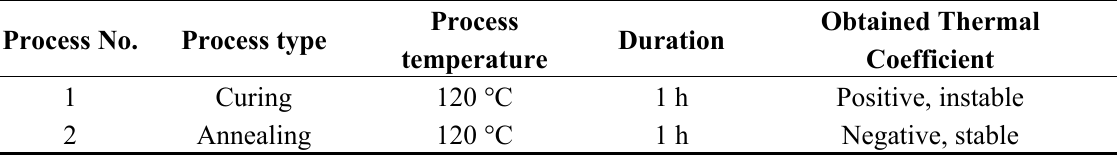
Table 3. Thermal treatment of nanotube paste.